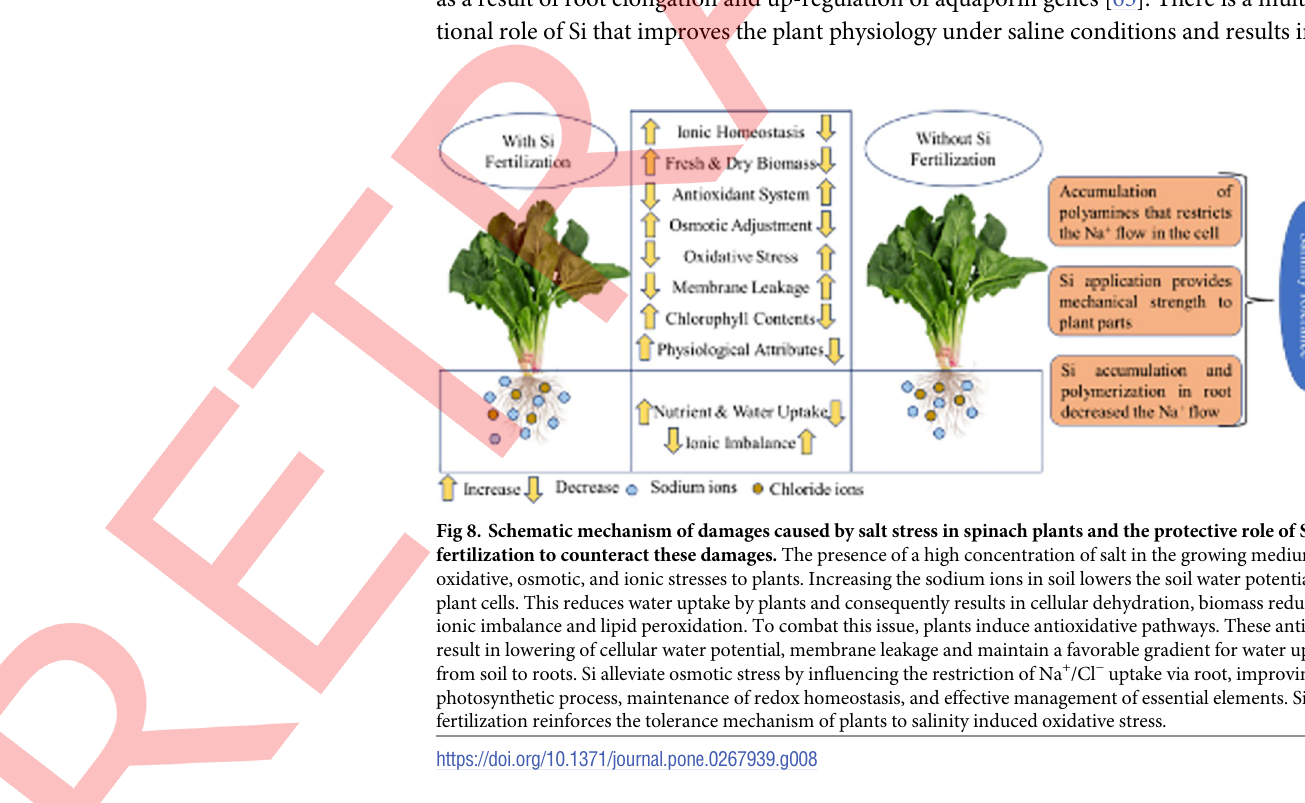
photosynthesis is reduced due to the inefficient utilization of light in spinach plants and the occurrence of photoinhibition that reduces stomatal conductance [60]. Abiotic stress causes a low transpiration rate to turgidity loss of guard cells [58, 61] in plants. The turgidity loss of guard cells causes stomatal cessation resulting in a reduced availability of CO which leads to a 2 decreased photosynthetic efficiency [58, 60]. By the use of Si fertilizer, leaves and stem epider- mal cells show minimum loss of water by reducing the rate of transpiration [62–64]. Silicon influences water relations in crop plants by inducing the development of a double layer silica cuticle under the epidermis of the leaf which decreases the loss of water through cuticular tran- spiration. Silicon increases the stress tolerance of crop plants by extracting water from the soil as a result of root elongation and up-regulation of aquaporin genes [65]. There is a multifunc- tional role of Si that improves the plant physiology under saline conditions and results in